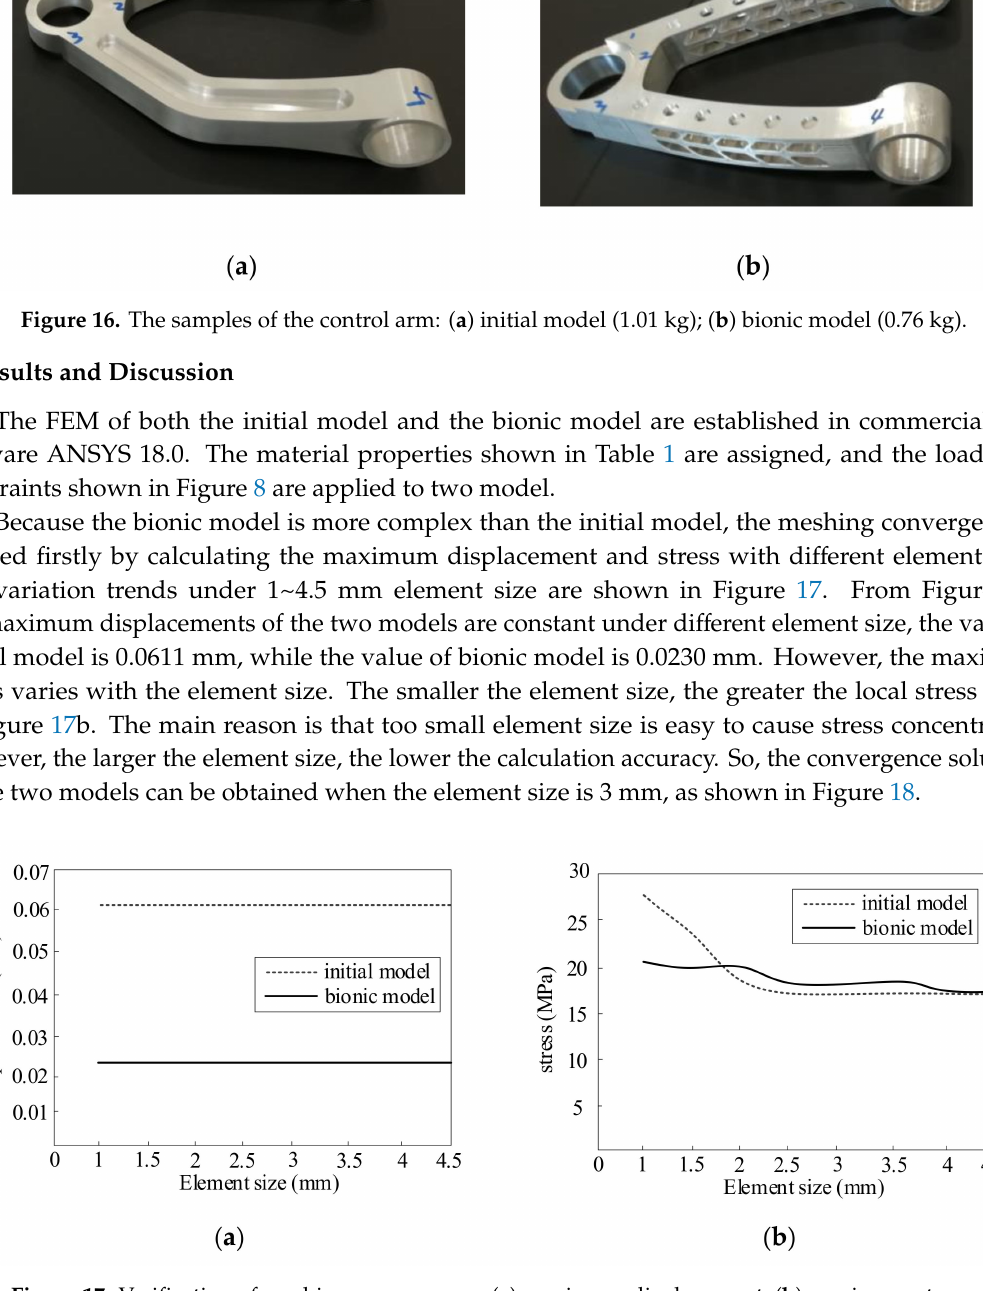
Figure 17. Verification of meshing convergence: ( a ) maximum displacement; ( b ) maximum